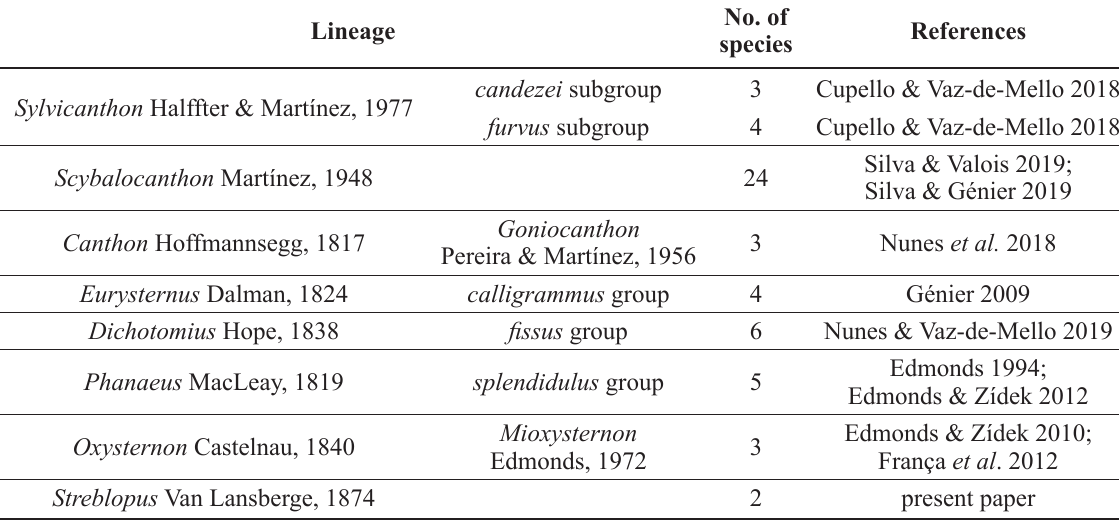
Table 5. Dung beetle lineages occurring in both the Amazonia and the Atlantic Forest, but absent from the South American Dry Diagonal. As discussed in the text, such a disjunct distribution was caused by the past existence of forest corridors connecting both forest biomes over several different periods of the